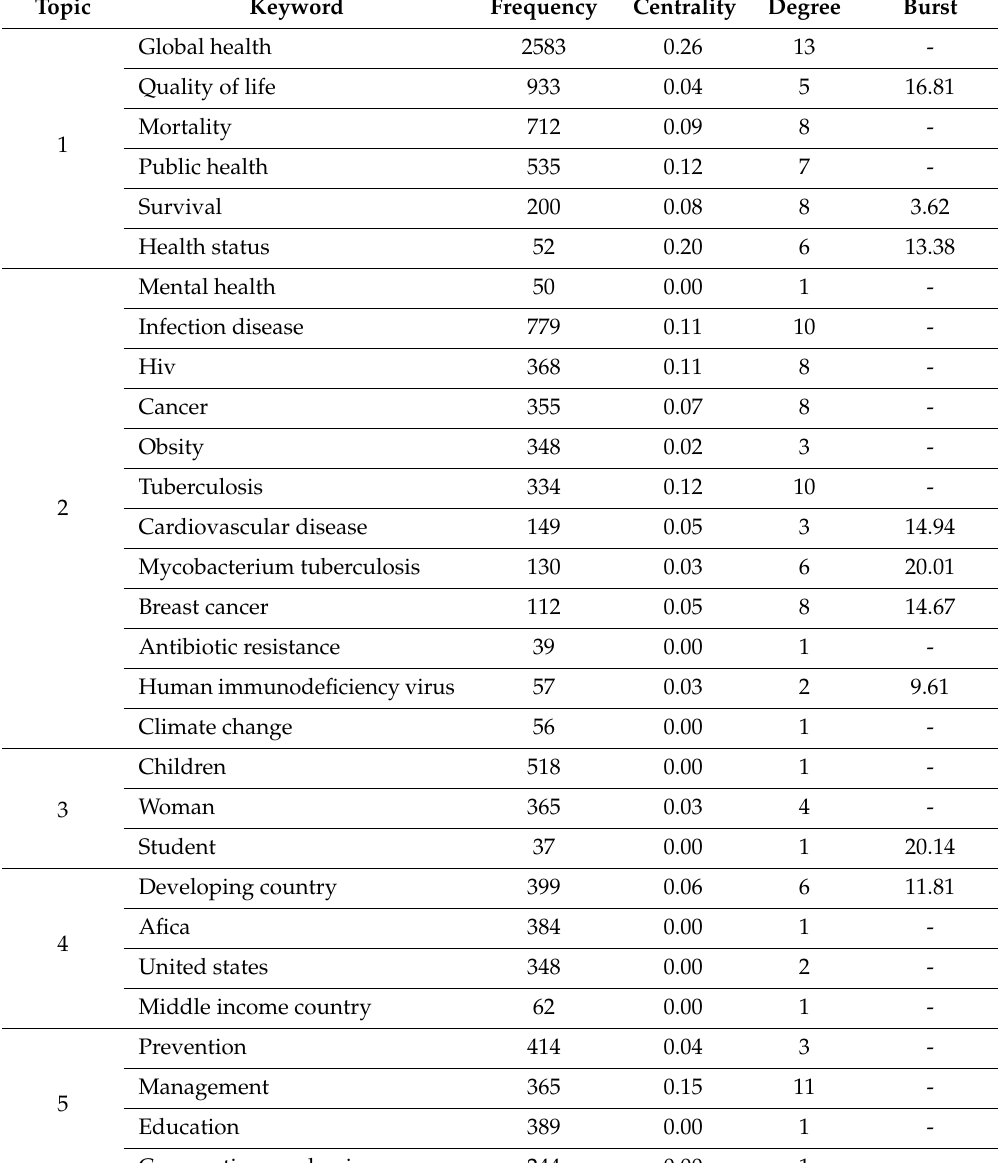
Table 5. List of keywords